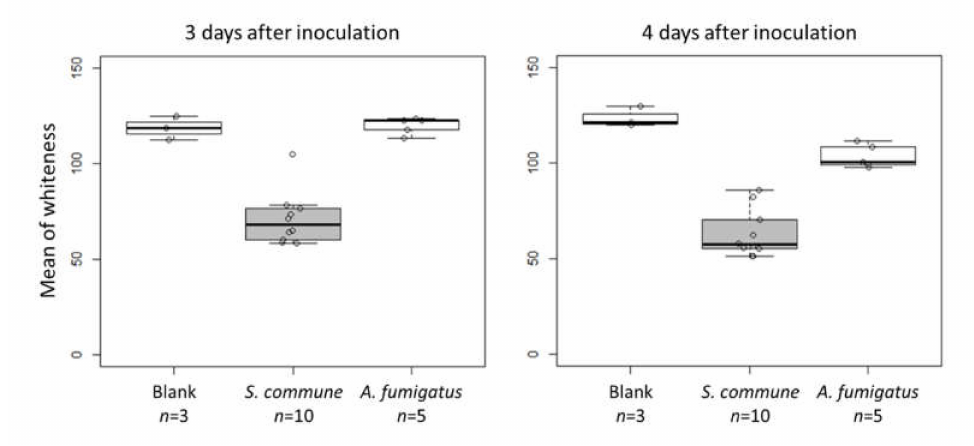
Figure 5. Detection of H 2 S using lead acetate paper. The whiteness of lead